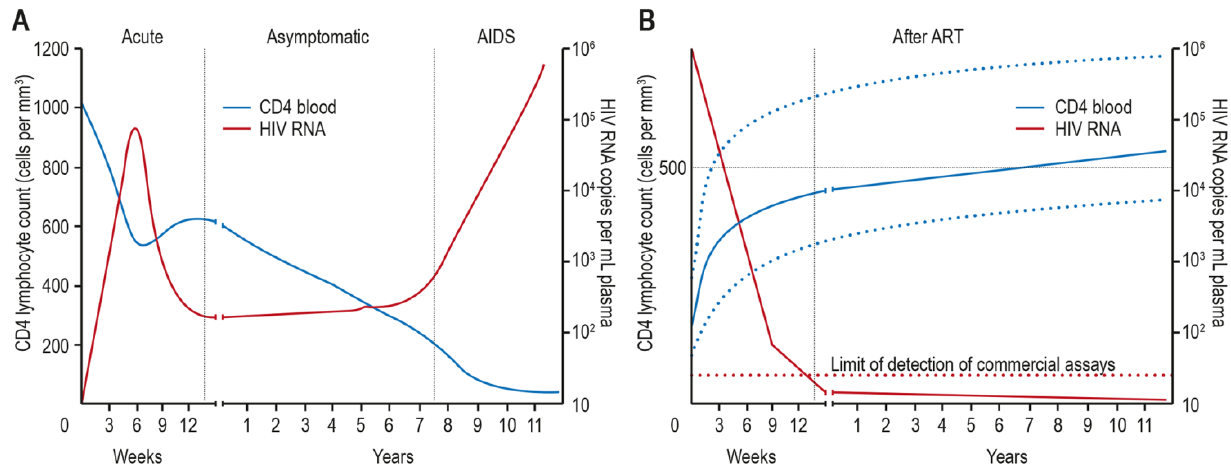
Figure 5: The course of untreated HIV infection and changes after antiretroviral therapy. In untreated HIV infection the blood CD4 T cell count progressively declines over the course of infection (A) . After initiation of antiretroviral therapy the HIV RNA copy numbers significantly decrease below detection limit followed by recovery of CD4 T cells, which can vary notably between individuals (B) . Adapted from